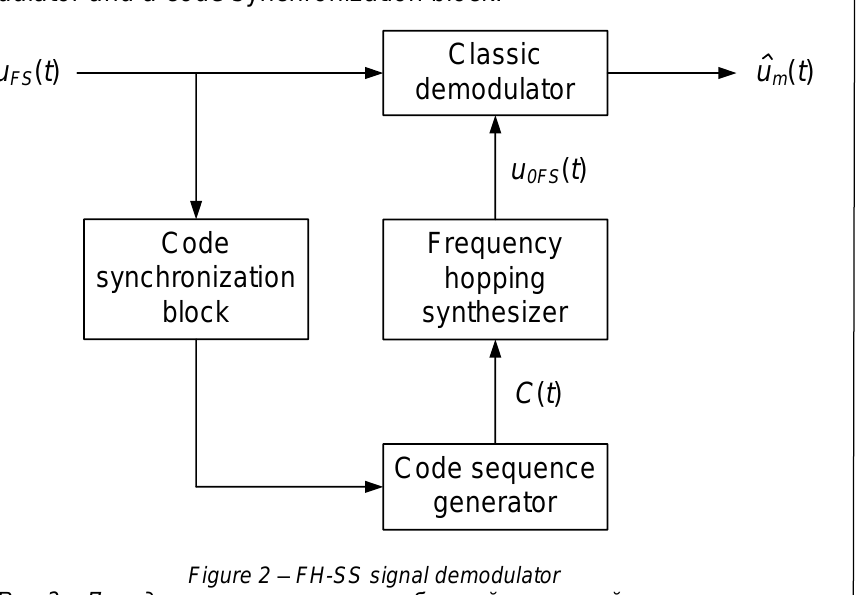
Figure 2 – FH-SS signal